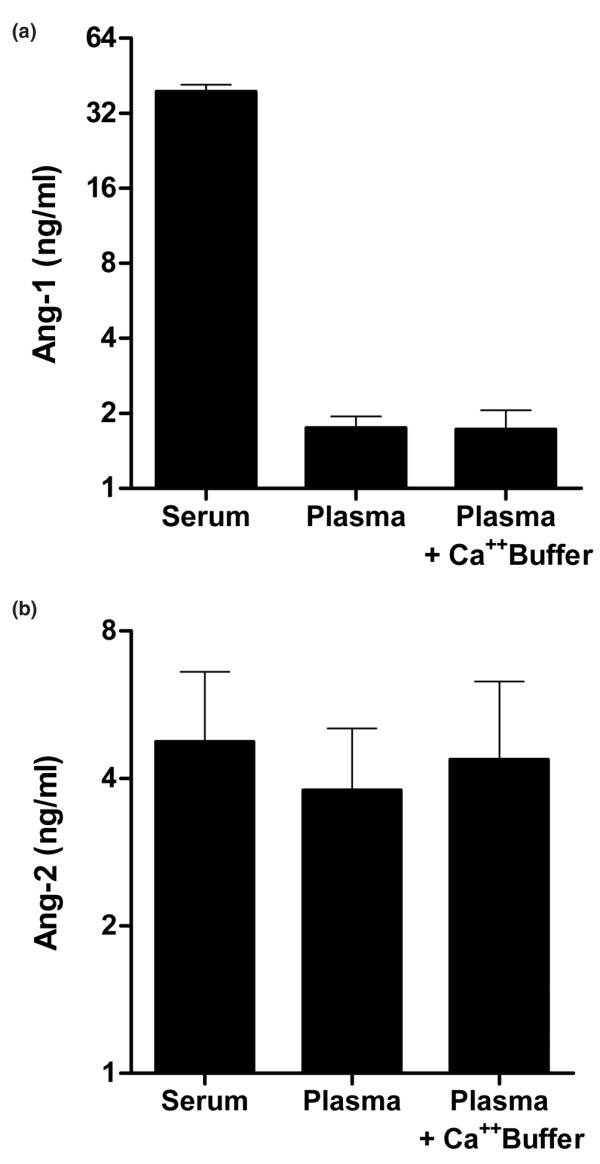
Comparison between detection of angiopoietin-1 and angiopoietin-2 concentrations in serum and plasma. (a) Angiopoietin-1 (Ang-1) and (b) angiopoietin-2 (Ang-2) concentrations were determined in parallel in serum and in ethylenediamine tetraacetic acid (EDTA) plasma samples obtained from the same five individuals. Importantly, the choice of anticoagulant matrix has a marked influence on Ang-1 measurement. Ang-1 was hardly detectable in EDTA-treated plasma, irrespective of the choice of buffer (calcium-supplemented buffer versus normal assay buffer; see Materials and methods). Ang-2 concentrations obtained from EDTA-treated plasma were lower (~80%) compared with values obtained from serum (100%). In contrast to Ang-1, the use of a calcium-supplemented buffer instead of the normal assay buffer could abolish the difference between serum and plasma for Ang-2.